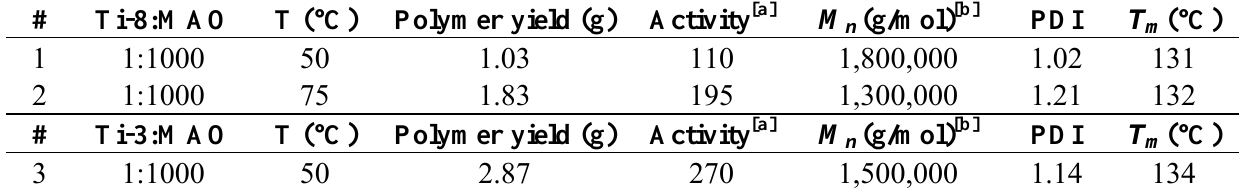
Table 1. Homopolymerization of ethylene using Ti-8 and Ti-3